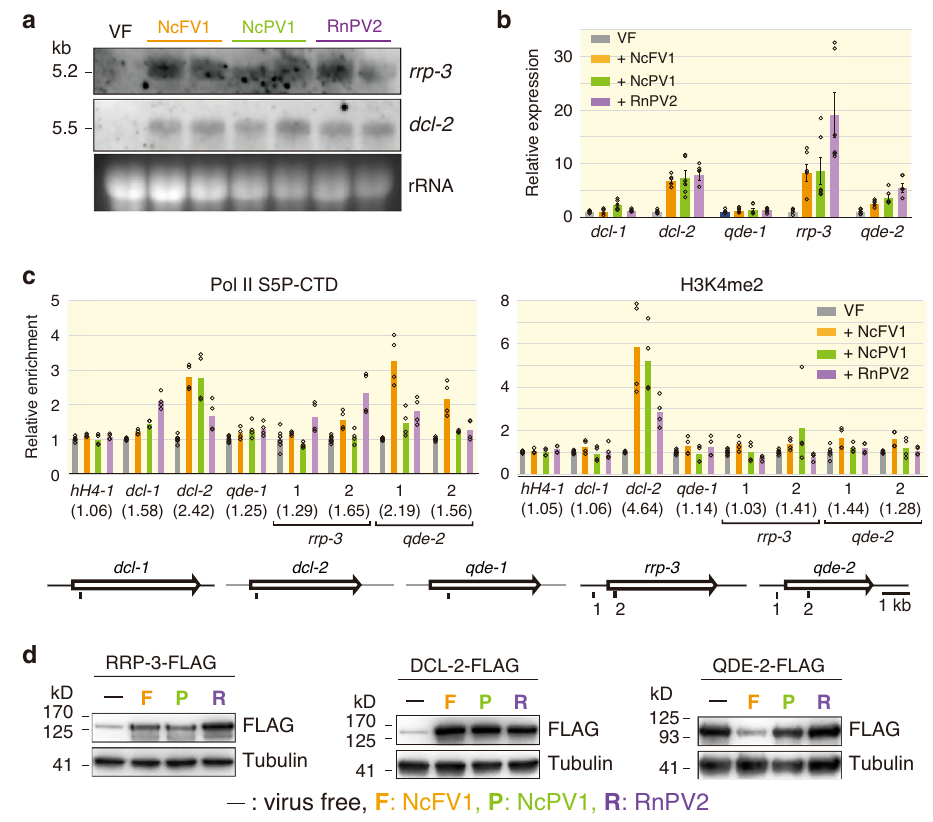
Fig. 5 Transcriptional and post-transcriptional regulation of RNAi-related genes in Neurospora crassa . a Northern blotting of rrp-3 and dcl-2 in NcFV1-, NcPV1-, or RnPV2-infected standard N. crassa strains, 74-OR23-1VA strains. b Real-time RT-qPCR analyses of several RNAi-related genes. Transcript levels of dcl-1 , dcl-2 , qde-1 , and qde-2 were compared between a virus-free (VF) standard N. crassa strain (74-OR23-1VA) and its virus-infected derivative strains by NcFV1, NcPV1, and RnPV2. Histone H4 mRNA ( hH4-1 ) was used as an internal control in ( b ) and ( c ). Mean values and standard deviations were calculated from three biological replicates and three technical replicates. A total of six obtained values are placed on each bar. c Chromatin immunoprecipitation (ChIP) assay of the standard N. crassa strain uninfected (VF) or infected by NcFV1, NcPV1, or RnPV2. DNA was isolated from immune precipitates with anti-H3K4me2 antibody (H3K4me2) or anti-RNA polymerase II CTD repeat YSPTSPS (Pol II S5P-CTD). Positions 1 and 2 refer to the ampli fi ed regions of the tested genes. Mean values were calculated from two biological replicates and two technical replicates. A total of four obtained values are placed on each bar. d Western blotting of RRP-3, DCL-2, and QDE-2. The standard N. crassa strain was engineered such that rrp-3-Flag , dcl-2- Flag , or qde-2-Flag was knocked in. Total protein fractions were prepared from the respective strain uninfected ( − ) or infected by NcFV1 (F), NcPV1 (P), or RnPV2 (R), were probed by anti-FLAG antibody. Alpha-tubulin was used a loading control. The experiments shown in panels a and d were repeated once and twice,